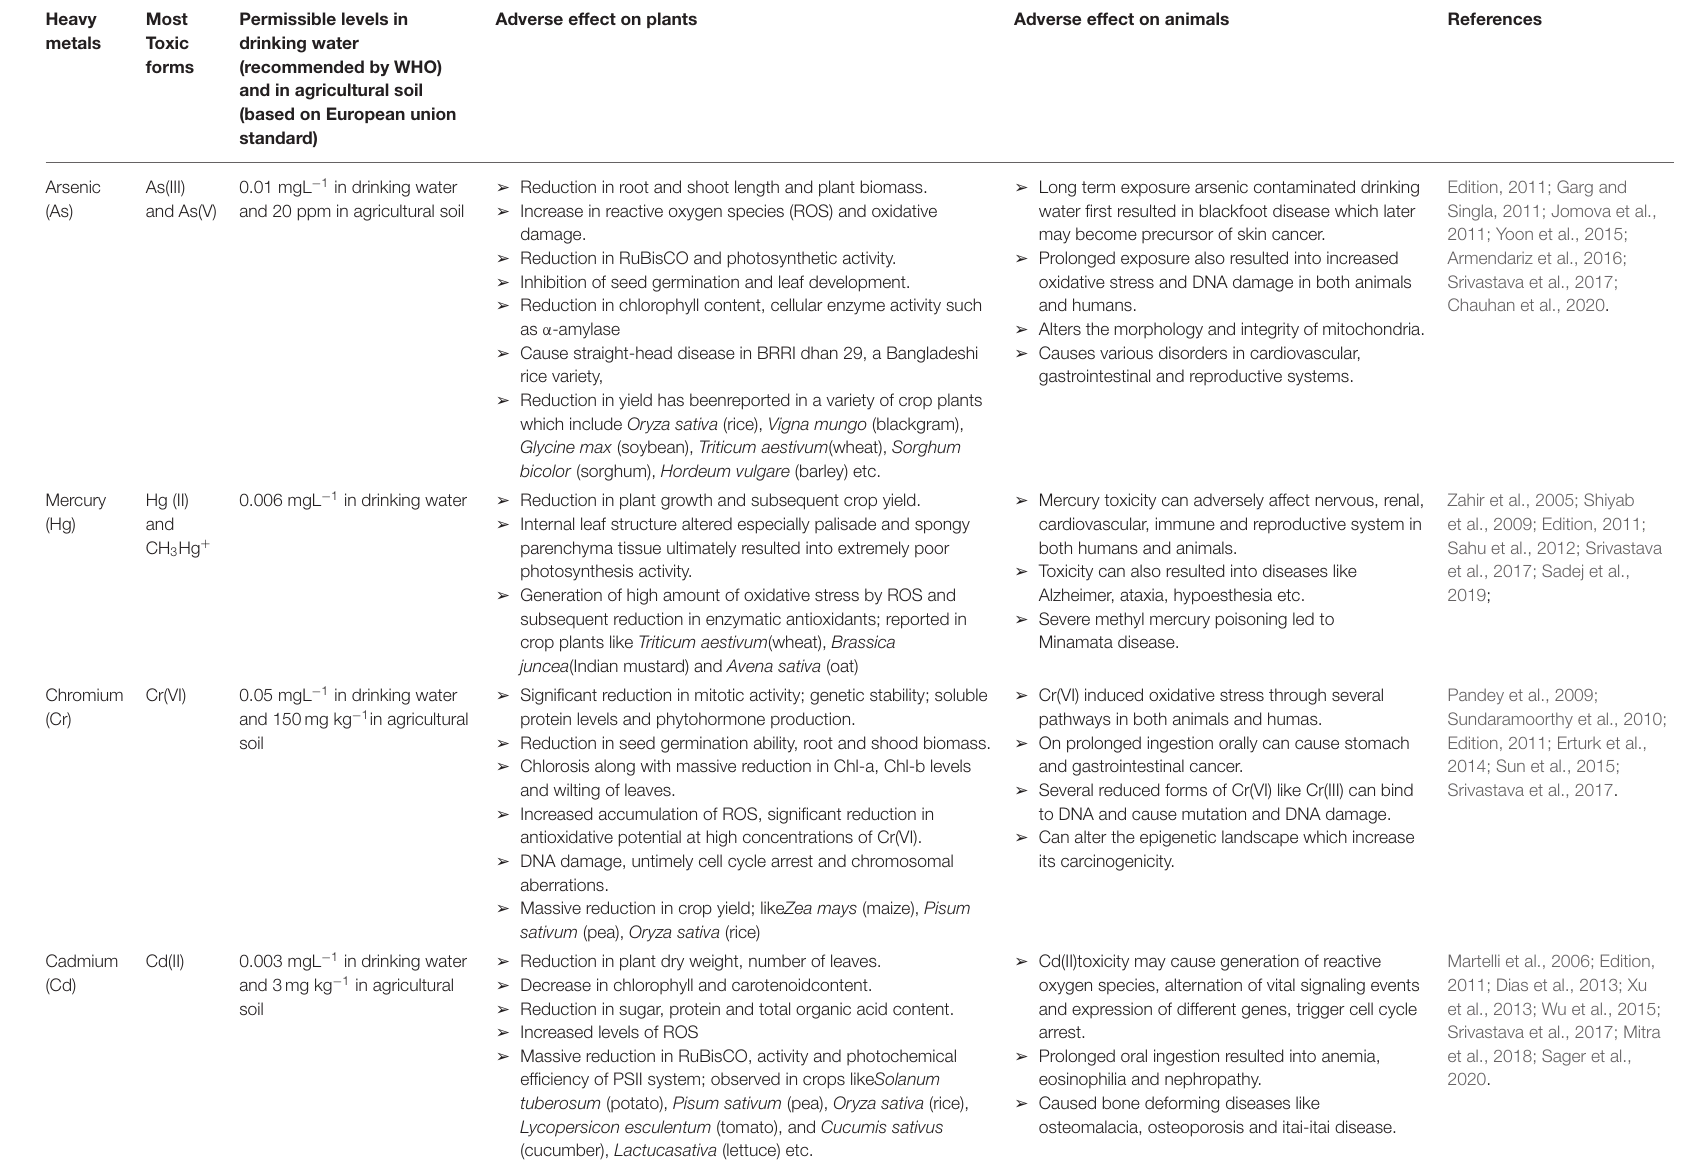
Adverse effect on